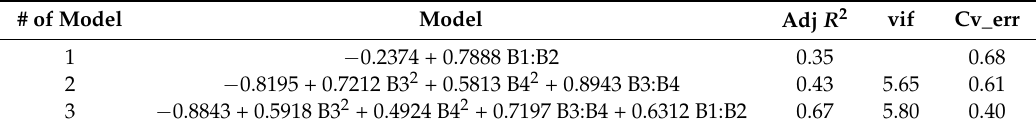
Table 4. Best models for K obtained with the indicators of Table A1.